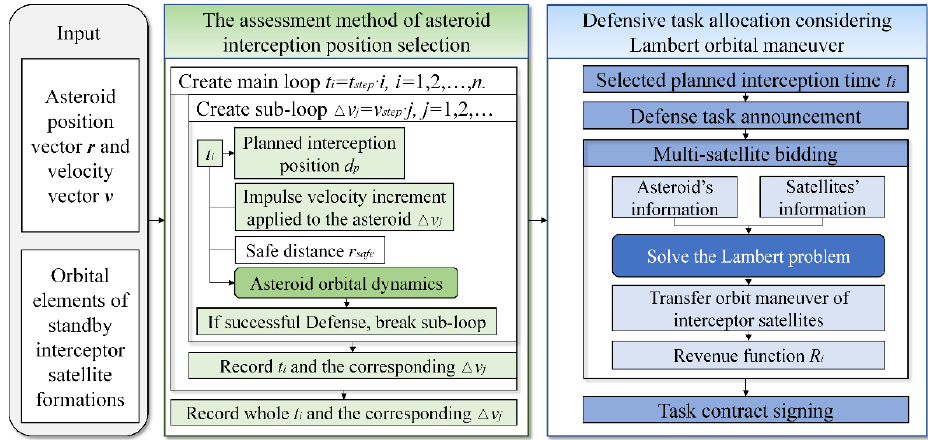
Figure 2. Flow chart of the proposed terminal asteroid defence method.